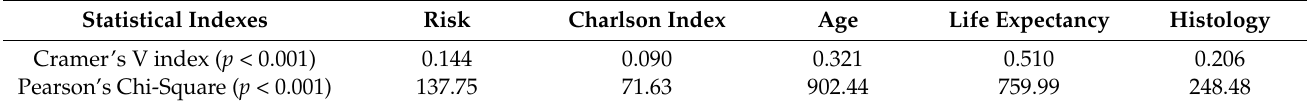
Table 2. Relationship of treatment with other variables.